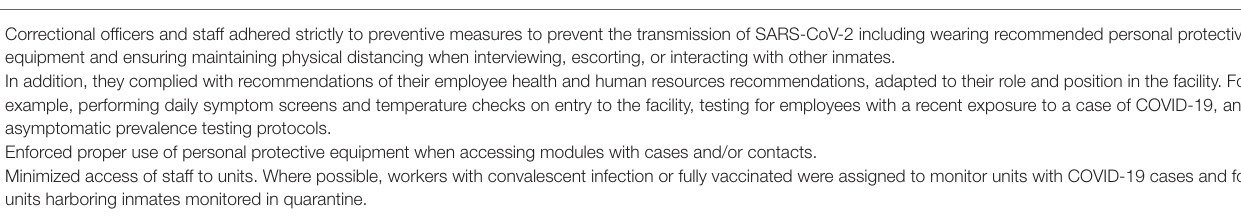
TABLE 2 | Summary of interventions implemented during the COVID-19 outbreak in the CPAII Prison in Alicante, Spain (January-April 2021). Facility management and operational response to the outbreak Restriction of population mobility inside the prison and from the outside: - Interrupted visitation of close contact interactions with family, intimate, or with others. - Restricted access to non-essential vendors, attorneys, monitors volunteers, and tours from entering the facility. - Suspended out-of-jail permits. - Increased number of allowable telephone communications and video calls of inmates. Sequestration of new admissions at the time of the initial intake and of those returning to the facility with an outside-prison permit: - Sequestered newly admitted inmates or transfers to the institution for a 14-day period in the intake unit. - Performed daily symptom screening, temperature checks and measurement of pulse oxygen saturation in all inmates. - Interrupted inmate transfers between CPAII and other facilities. Suspension of activities involving interaction between modules: - Interrupted group activities, workshops and training, teaching, sports competitions, and other activities of a similar nature that, not being essential, may pose a risk of contagion. - Performed essential trustee/detail activities -kitchen, cleaning, etc.- in shifts or by group, so that all the people working in the same shift or equipment must come from the same module. Population Isolation: - Confined inmates in their units and avoided transfers among different